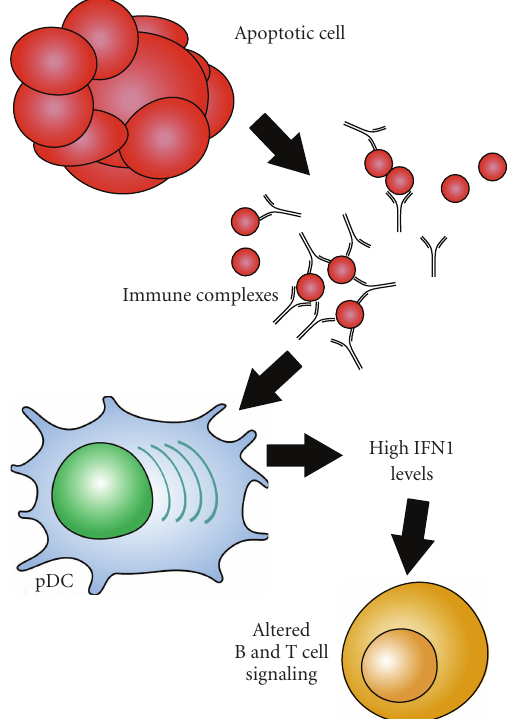
Figure 1: Putative source and e ff ects of interferon alpha in lupus. RNA-containing complexes from apoptotic cells are bound by autoantibodies. These immune complexes are internalized after binding to FC receptors on plasmacytoid dendritic cells and stimulate toll-like receptors in the endosomes. Toll-like receptor ligation drives production of interferon alpha, leading to alteration of T-cell profiles, disruption of regulatory T-cell networks, and alteration of B-cell